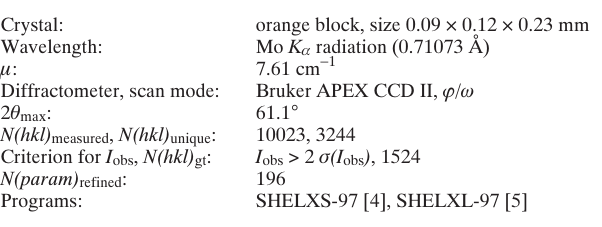
Table 1. Data collection and